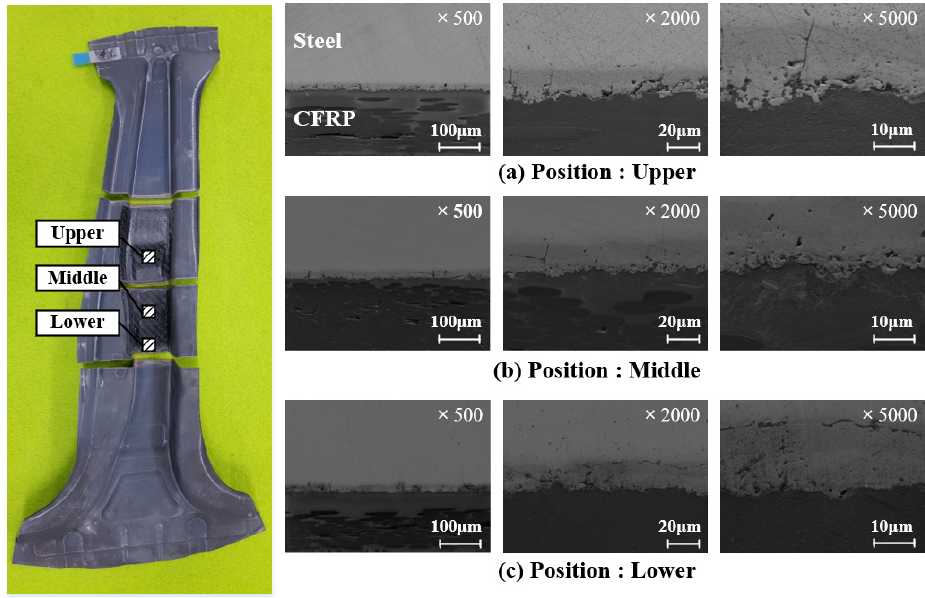
Figure 17. Observation results of the interlayer behavior by SEM.